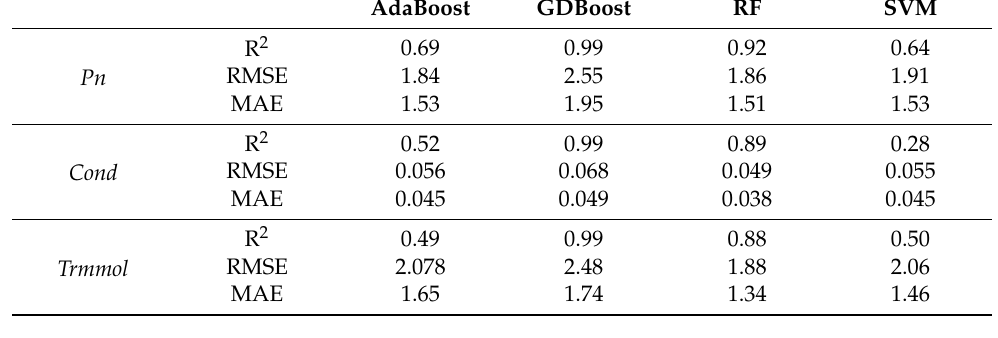
Table 4. The machine-learning algorithms’ accuracy performance for the reflectance data.